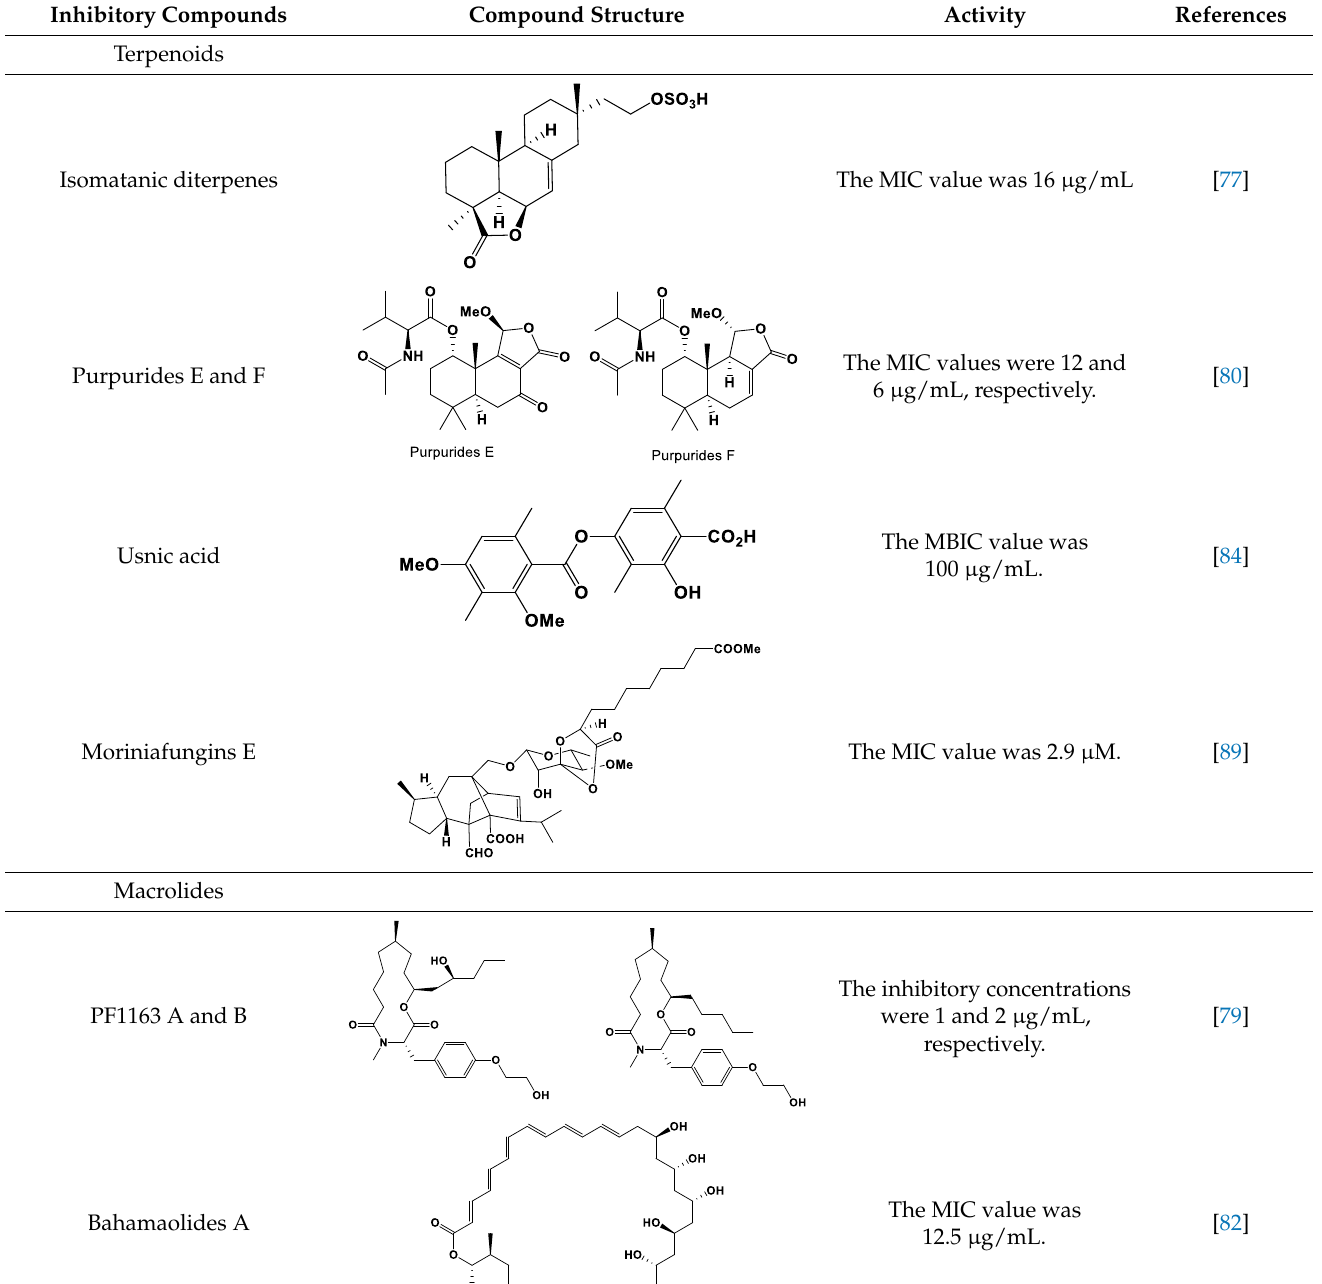
Table 3. The structures and activity of compounds against C. albicans.